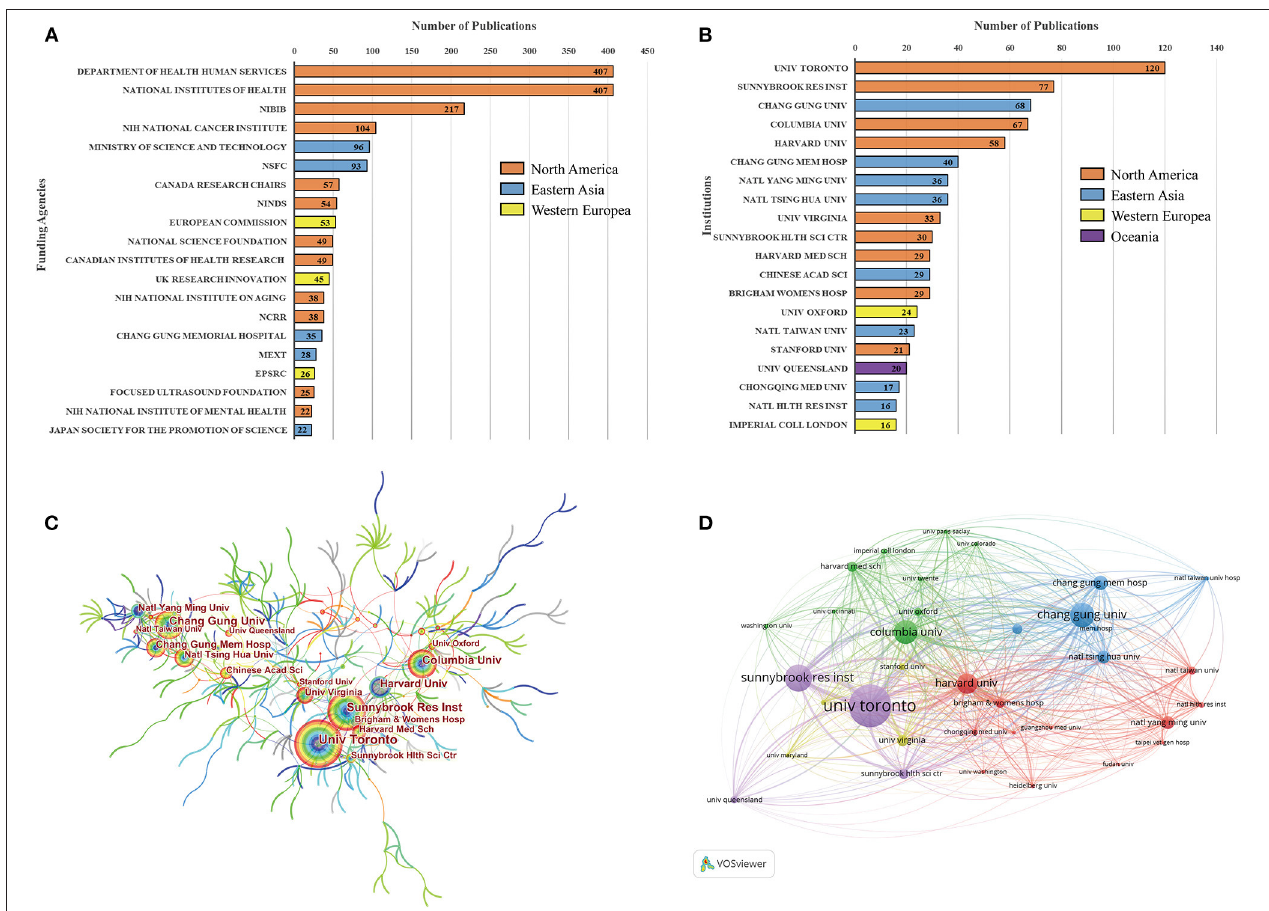
FIGURE 5 | (A) The top 20 funding agencies for the output of ultrasound-induced BBB opening research. NIBIB, NIH National Institute of Biomedical Imaging Bioengineering; NSFC, National Natural Science Foundation of China; NINDS, NIH National Institute of Neurological Disorders Stroke; NCRR, NIH National Center for